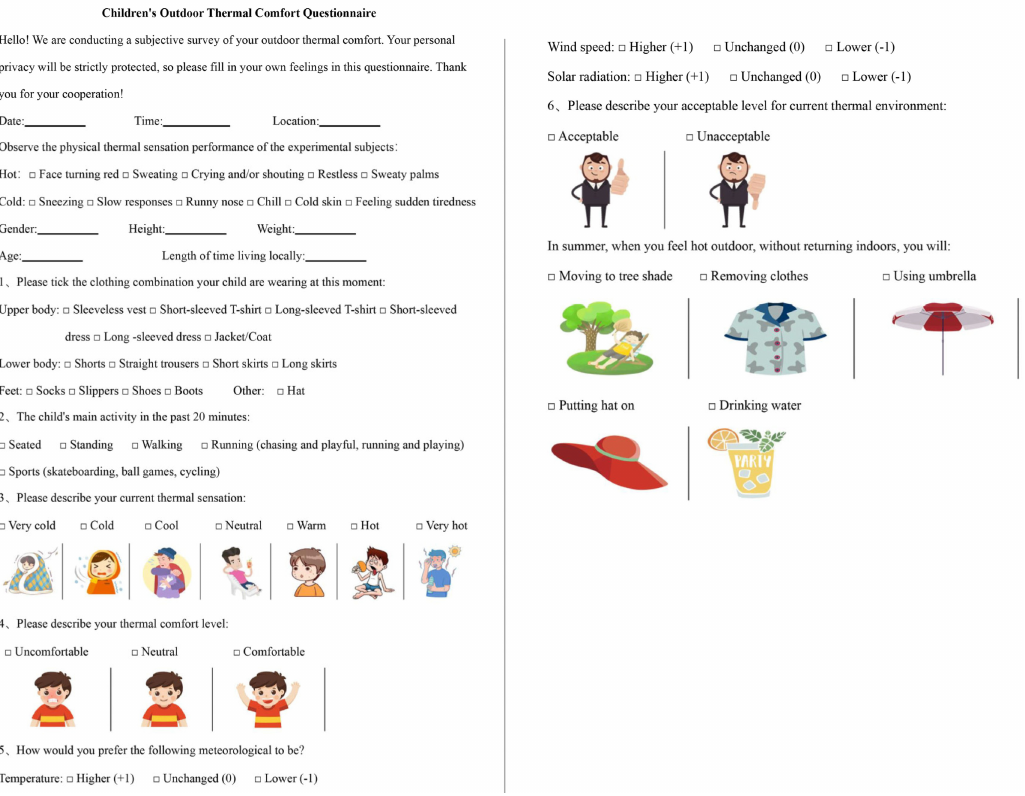
Figure A1. Children’s outdoor thermal comfort